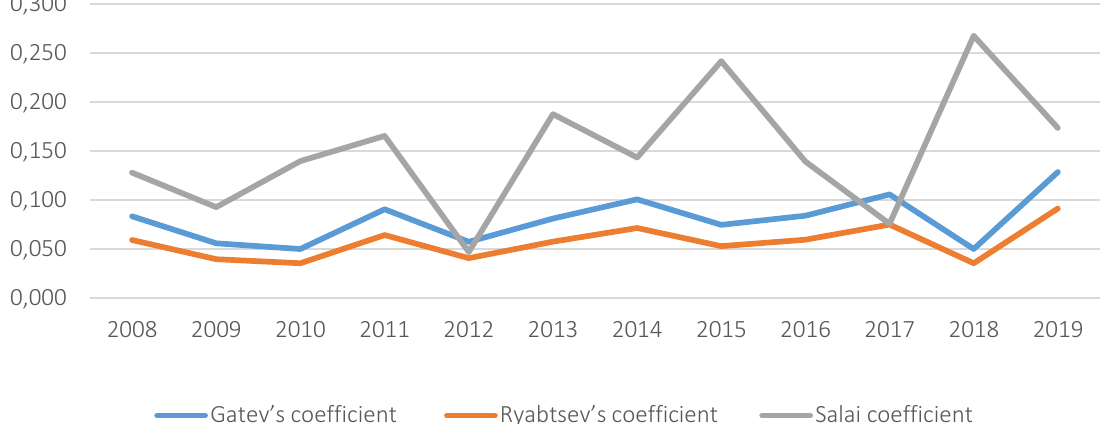
Figure 2. Dynamics of integrated coefficients of structural changes in the expenditure side of the state budget of Ukraine